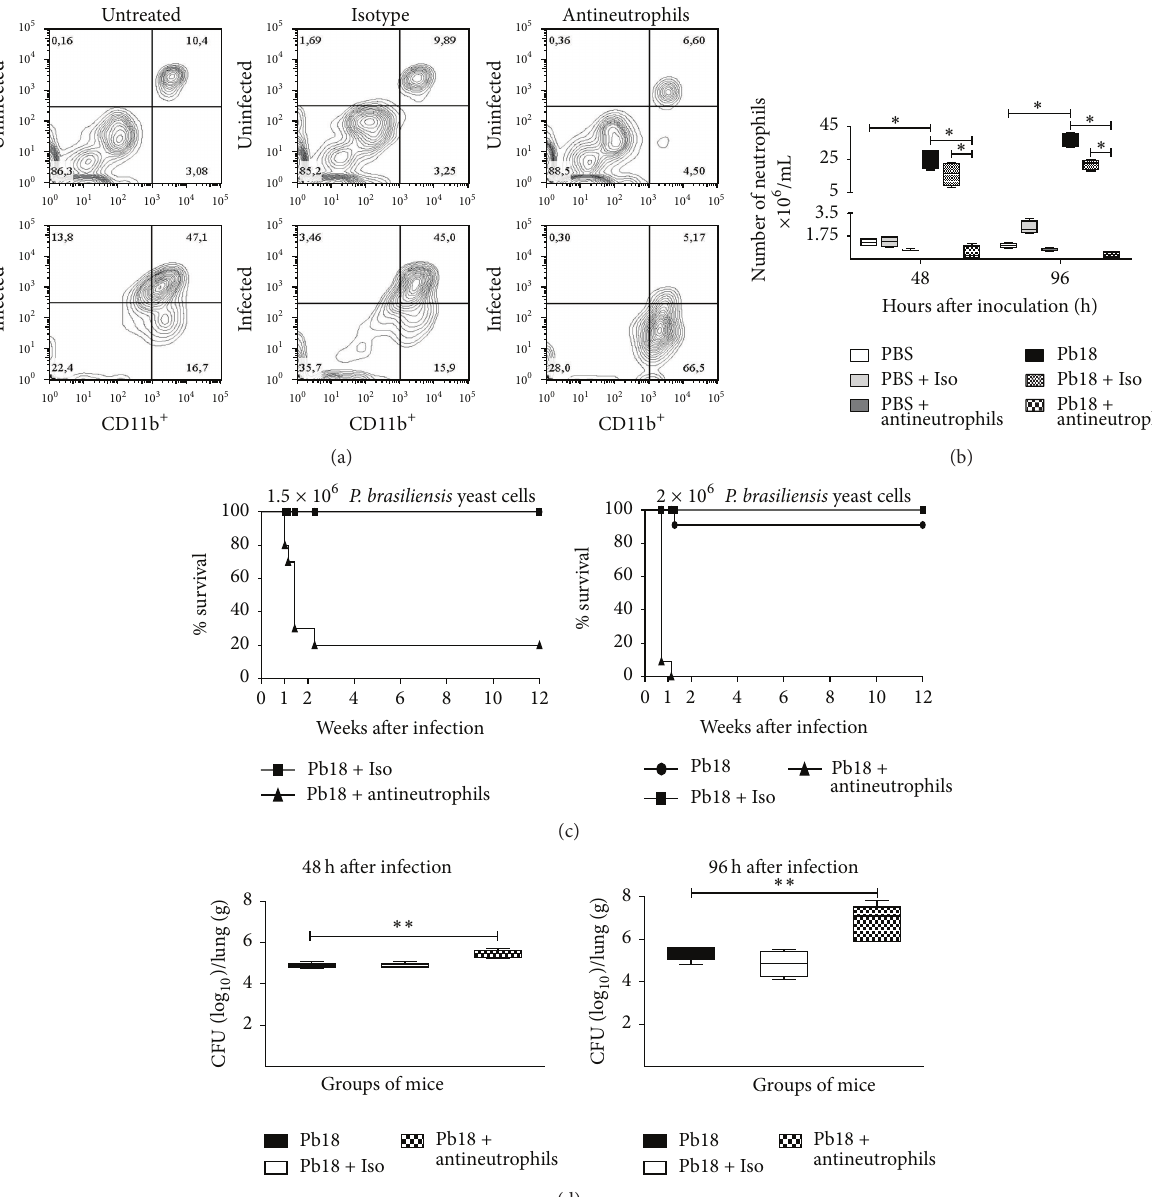
Figure 1: The anti-Ly6G mAb efficiently depleted neutrophils demonstrating their essential role during the early stages of P. brasiliensis infection. BALB/c mice were intranasally inoculated with PBS or 1.5 × 10 6 P. brasiliensis (Pb18) yeast cells, treated with an isotype control Ab or the anti-Ly6G specific mAb against neutrophils, and analyzed during the acute phase of P. brasiliensis infection (48h and 96h after challenge). Neutrophils were assessed by flow cytometry as described in the Materials and Methods section, which were identified as CD45 + /CD11b + /Gr1 + . (a) Representative flow cytometry contour plots of neutrophils within the gated CD45+ subpopulations are shown. Numbers inside the gates indicate the mean percentages of the gated subsets. (b) Bar plots of the neutrophils per lung. Data shown represent median and IQR ( 𝑛 = 4 -5 mice/group; representative of two independent experiments). ∗ 𝑃 < 0.05 comparing infected-untreated mice versus control mice or comparing infected-anti-Ly6G mAb-treated mice versus infected-untreated mice. (c) BALB/c mice were challenged intranasally with 1.5 × 10 6 or 2 × 10 6 P. brasiliensis yeast cells, treated as previously described, and evaluated over 12 weeks. Results are representative of two independent experiments ( 𝑛 = 10 -11 mice/group). A statistically significant difference between the survival plots of the anti-Ly6G and the isotype or untreated mice was determined ( 𝑃 < 0.001 ). (d) Comparison of fungal burden in the lungs of BALB/c mice infected intranasally with 1.5 × 10 6 P. brasiliensis yeast cells, treated or not as previously described, and sacrificed at 48 h and 96 h after challenge. Data shown represent median and IQR ( 𝑛 = 4 -5 mice/group; representative of two independent experiments). A statistically significant increase in fungal burden was observed in the lungs of infected mice treated with the anti-Ly6G mAb ( ∗∗ 𝑃 < 0.01 ) compared to the infected-untreated mice and the infected-isotype control Ab treated mice. PBS, control mice; PBS + Iso, control mice treated with isotype control Ab (clone: 2A3); PBS + antineutrophils, control mice treated with anti-Ly6G mAb (clone: 1A8); Pb18, infected-untreated mice; Pb18 + Iso, infected mice treated with isotype control Ab; Pb18 + antineutrophils, infected mice treated with anti-Ly6G